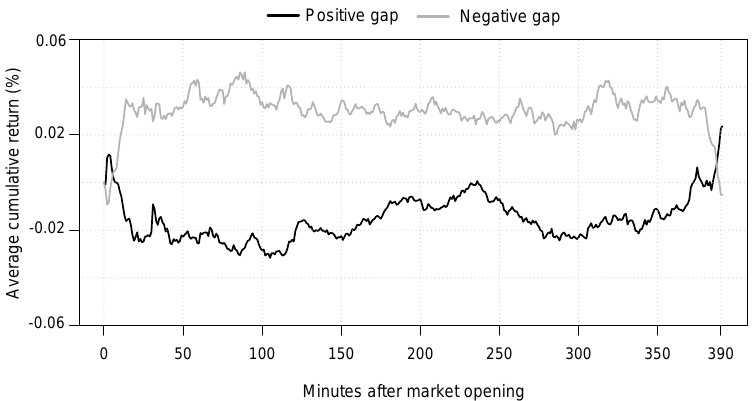
Figure 3. Average cumulative returns (%) after positive and negative overnight gaps, which were identified by the BNS jump test, from January 1998–December